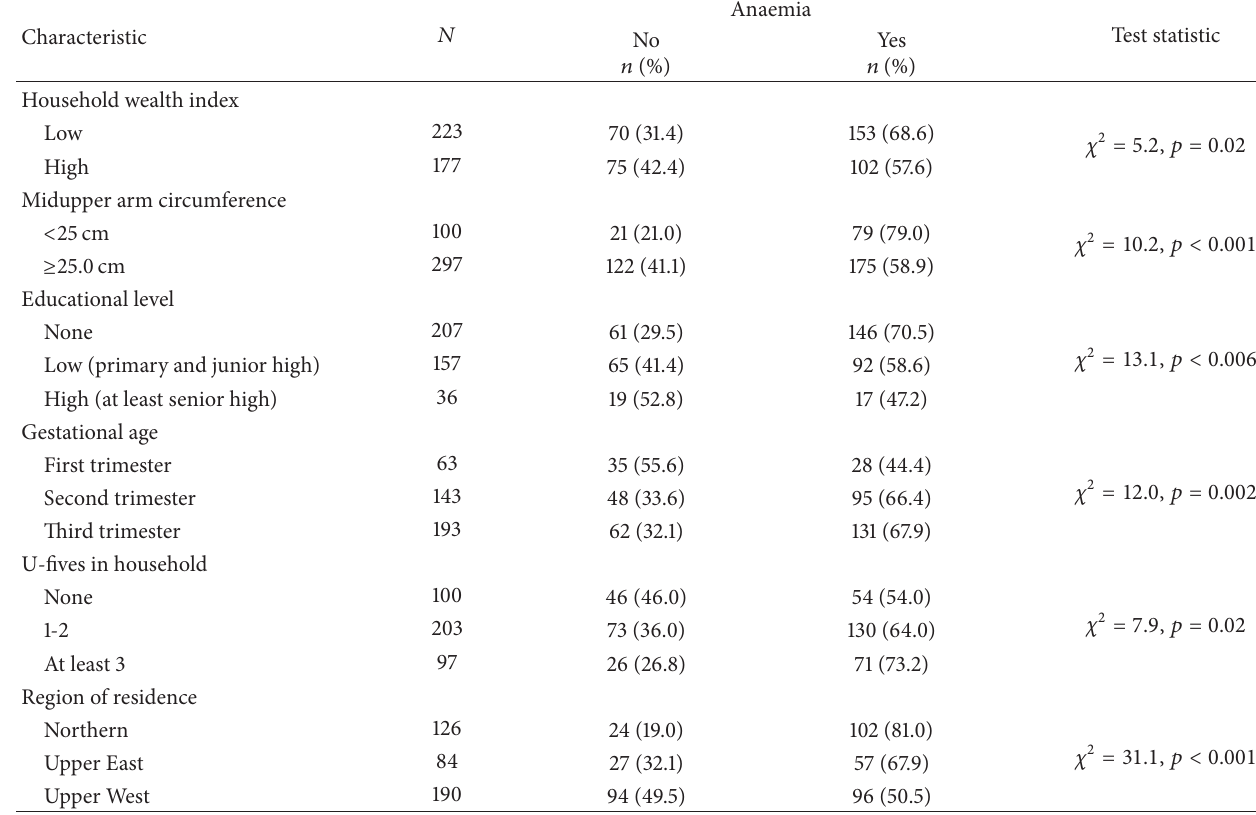
Table 3: Bivariate analyses of factors associated with anaemia of pregnant women ( 𝑛 = 400 ).